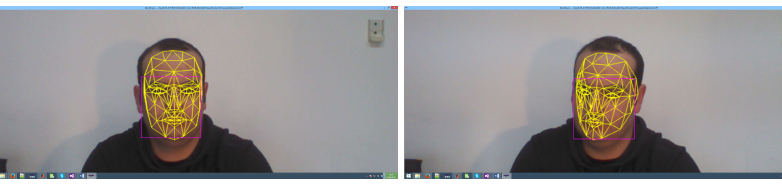
Figure 3. Two outputs of the head pose estimation